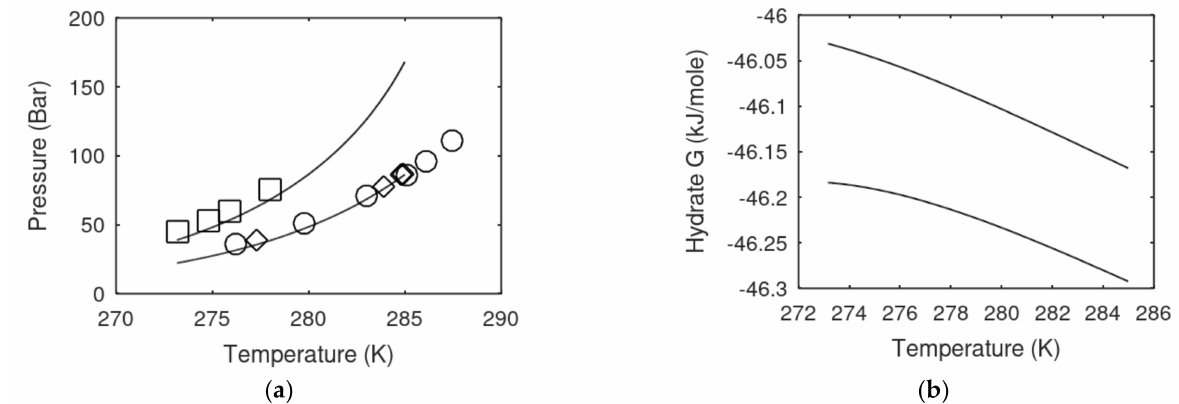
Figure 3. ( a ) CH 4 hydrate stability limits in temperature-pressure projection. Lower solid curve is calculated from pure water. Circles are experimental data from Sabil et al. [22] for hydrate from pure water. Diamonds are experimental data from Tumba et al. [23]. Upper solid curve is calculated for hydrate formed from CH 4 and water containing 0.0394 mole-fraction NaCl. Squares are experimental data from deRoo et al. [24] for hydrate formed from CH 4 and water containing 0.0394 mole-fraction. ( b ) Gibbs free energy for hydrate formed from CH 4 and pure water (lower solid curve) and Gibbs free energy for hydrate formed from CH 4 and water containing 0.0394 mole-fraction NaCl (upper solid